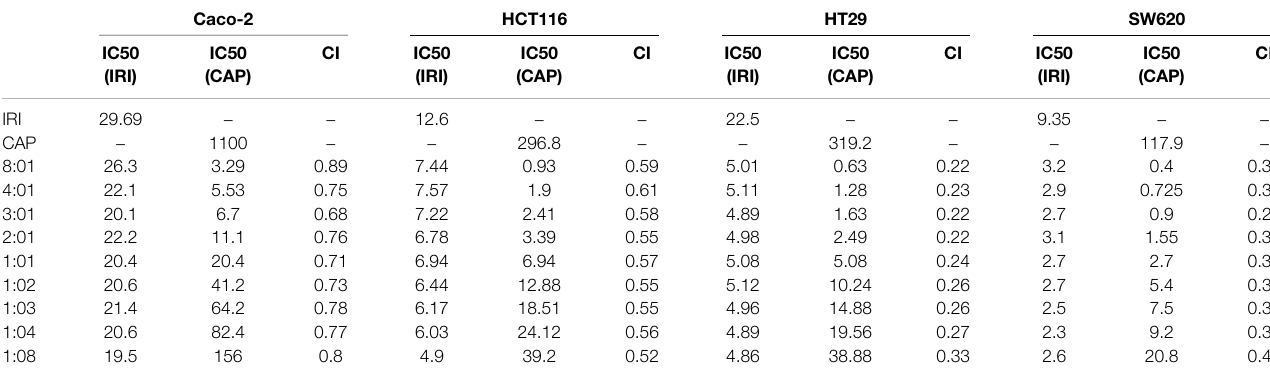
TABLE 1 | CI values for four colorectal cancer cell lines at different combination ratios of IRI/CAP.